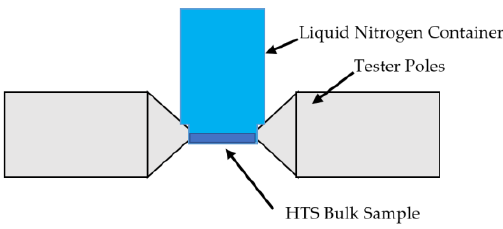
Figure 2. Arrangement of the HTS sample and liquid nitrogen box in SST.